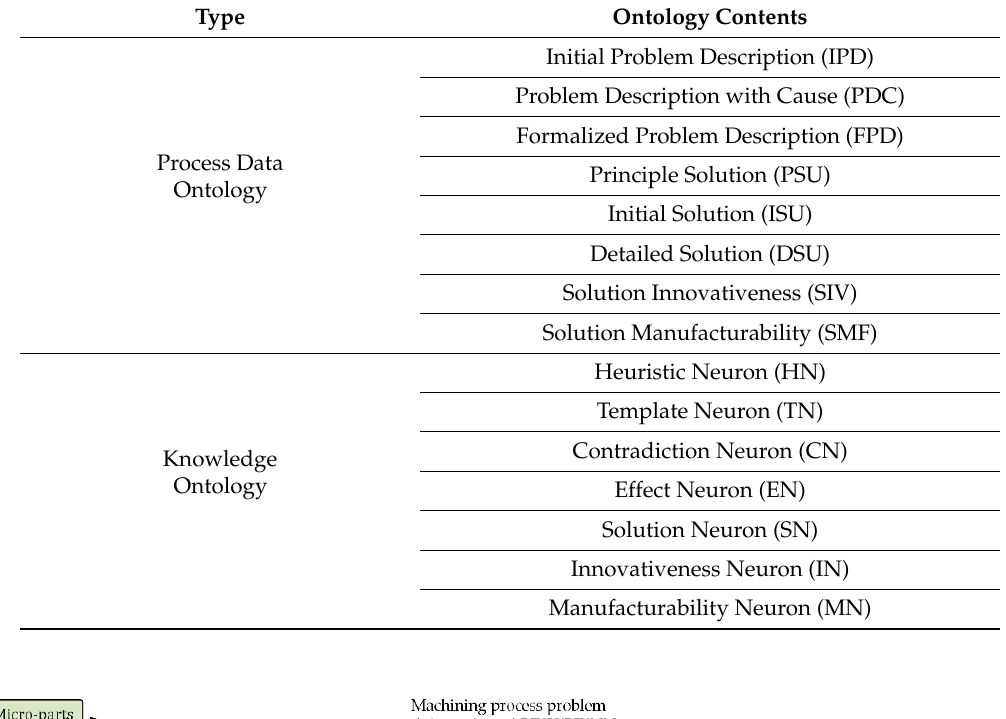
Table 2. The basic ontologies for machining process innovation.